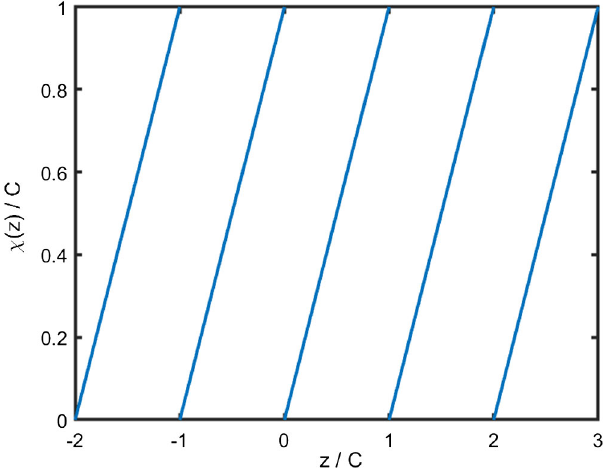
FIG. 1. The sawtooth function χ ð z Þ . Its value at jumps is defined by the limit from the left.